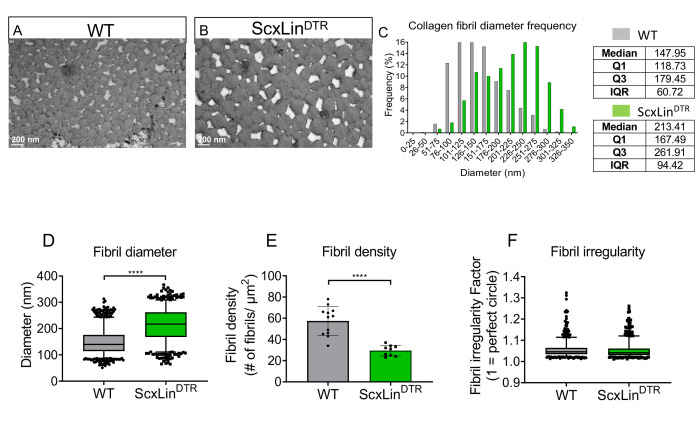
Collagen fibrils exhibit an altered diameter and density at 3 months post-depletion.Representative TEM images of the WT and ScxLinDTR FTs at 3 months post-depletion (A, B). Collagen fibril diameter histogram demonstrates an increase in the median fibril diameter in DTR D90 FTs compared to WT (C). Collagen fibril diameter of the WT and DTR D90 FTs with boxplot whiskers spanning data between the 5th and 95th percentiles; data outside this range are plotted as individual points (D). Collagen fibril density of the WT and DTR D90 FTs (E). Collagen fibril irregularity of the WT and DTR D90 FTs (F). N = 4 for WT and N = 3 for DTR D90. Student’s t-test used to assess statistical significance between genotypes. ****indicates p<0.0001.